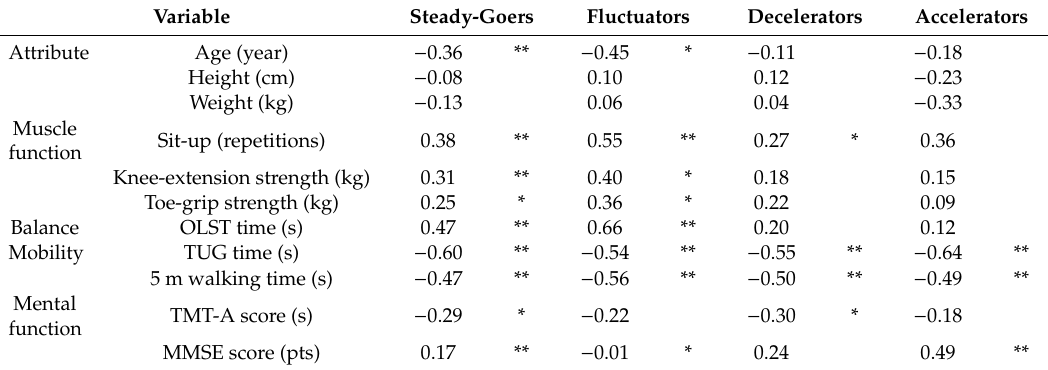
Table 3. Correlations of CS-30 performance (total cycles) with assessment